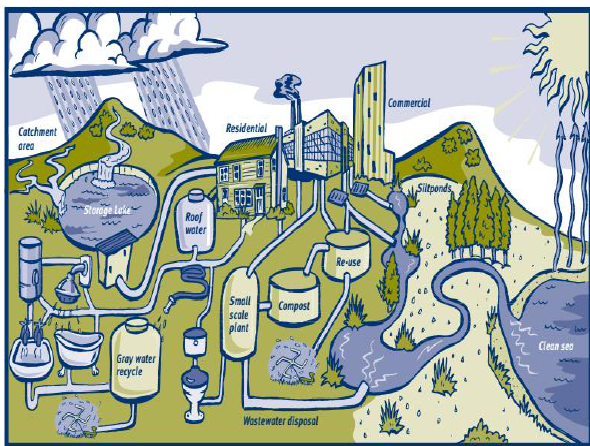
Figure 2. Ecological sanitation “treatment and recycling” (Ferguson et al., 2003)